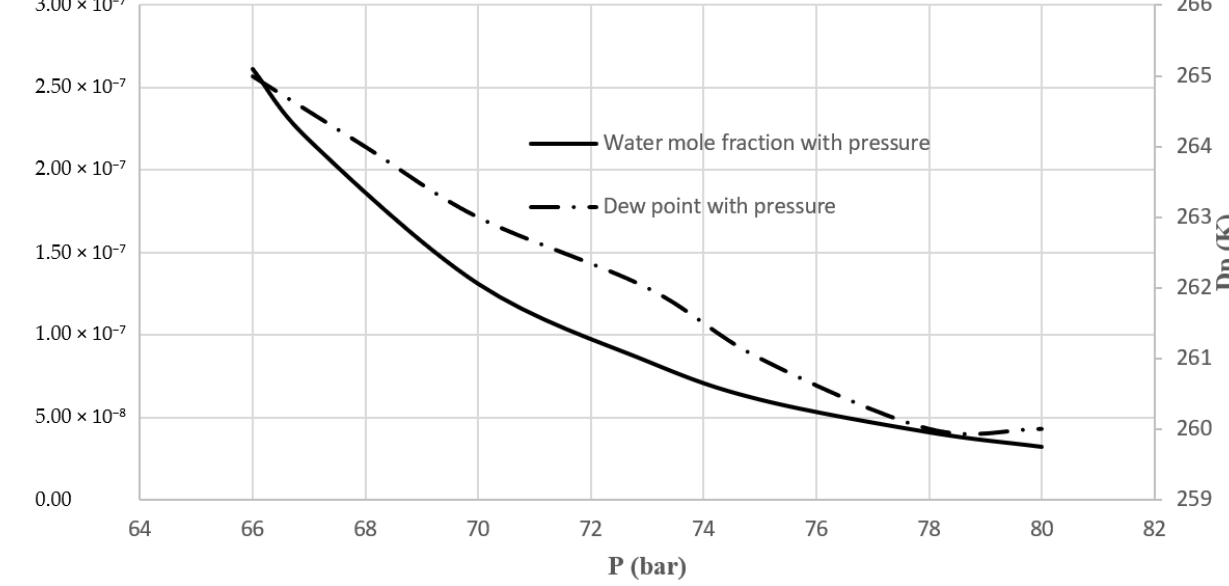
Figure 19. Pressure effect on dew point and water mole fraction in output stream.